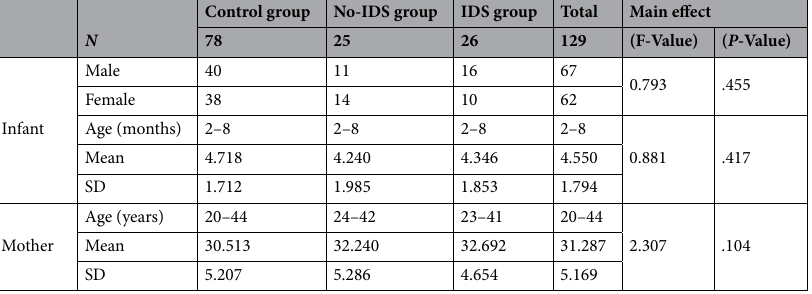
Table 2. Basic characteristics of the